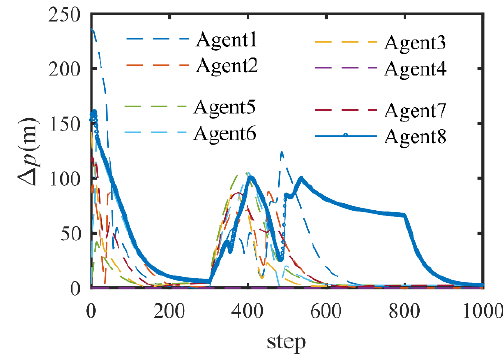
Figure 12. Position errors (test 3).